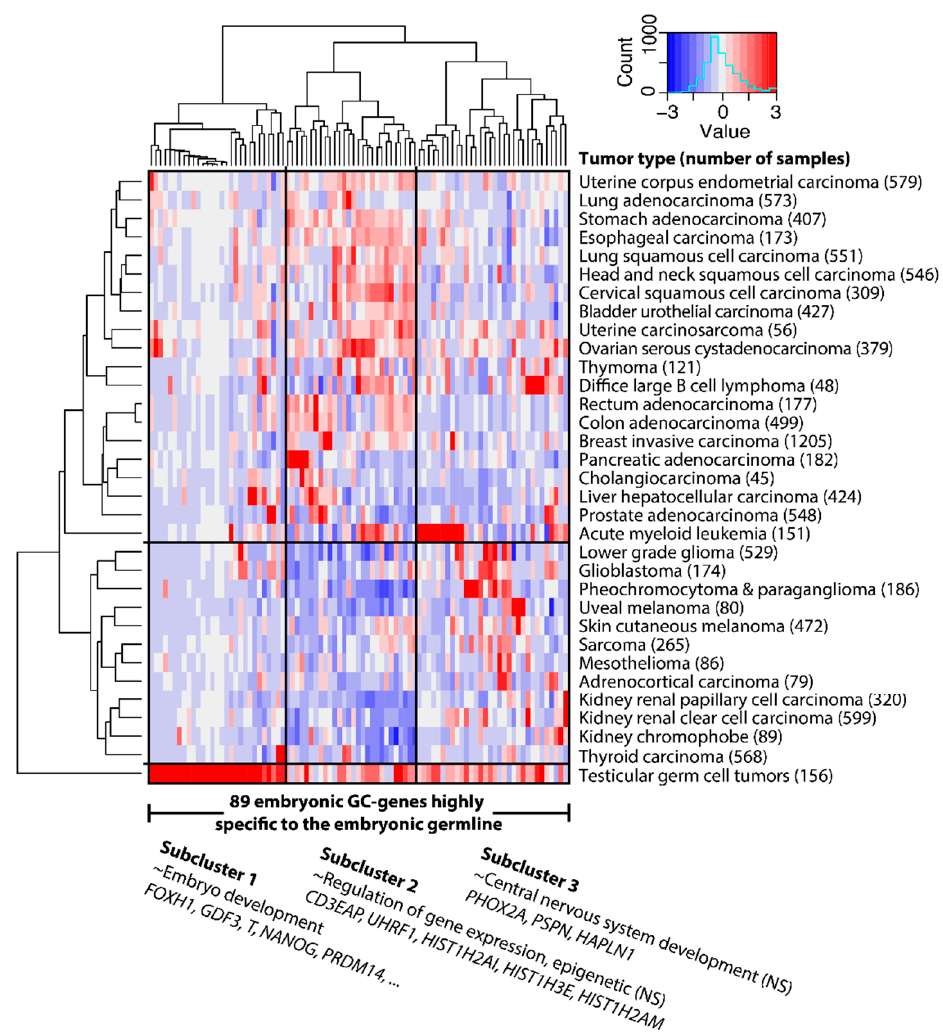
Figure 5. A subset of 89 embryonic GC genes highly specific to the embryonic germline are not only expressed in germ cell tumors, but also in many tumors that originate from tissues of somatic origin. Representative GO terms and some associated genes are known. GO terms are not significantly (NS) enriched, possibly due to the small sample sizes of subclusters. Clusters in Figure 2A and subclusters in Figure 5 were derived independently.